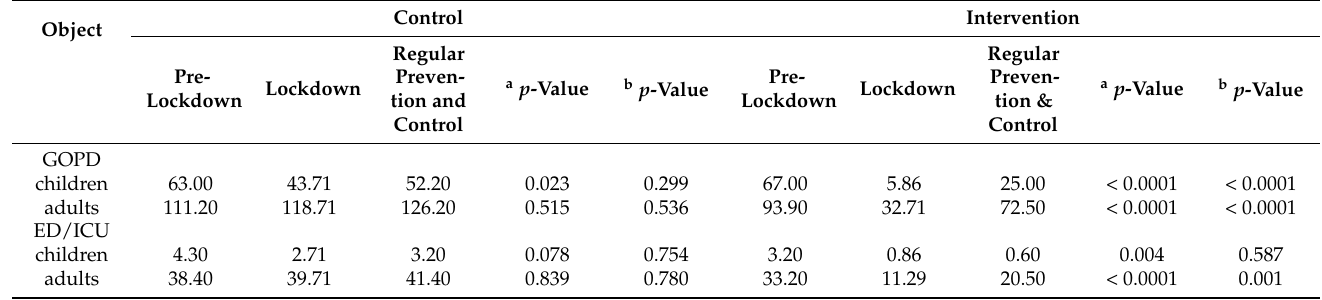
Table 1. Hospital and outpatient visits of asthma patients at each stage [average weekly